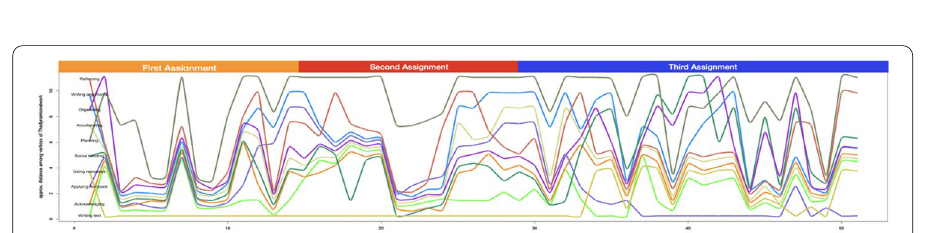
Fig. 7 Timeline of the longitudinal relations between SRL tactics during the three assignment